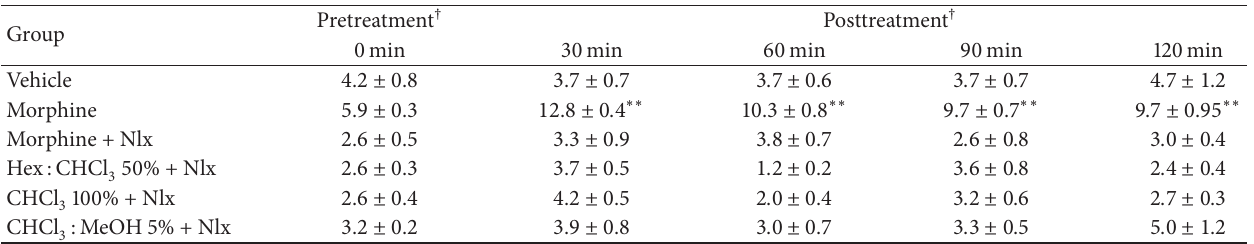
50%, CHCl 100%, and CHCl :MeOH 5% in the hot plate test, in the presence of the drug nalaxone. 3 3 3